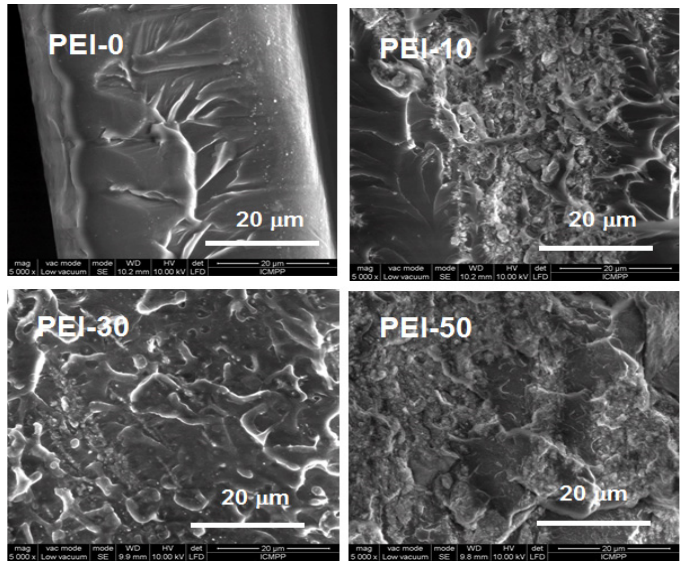
Figure 1. SEM micrographs of the cross-sections of the PEI/CoFe 2 O 4